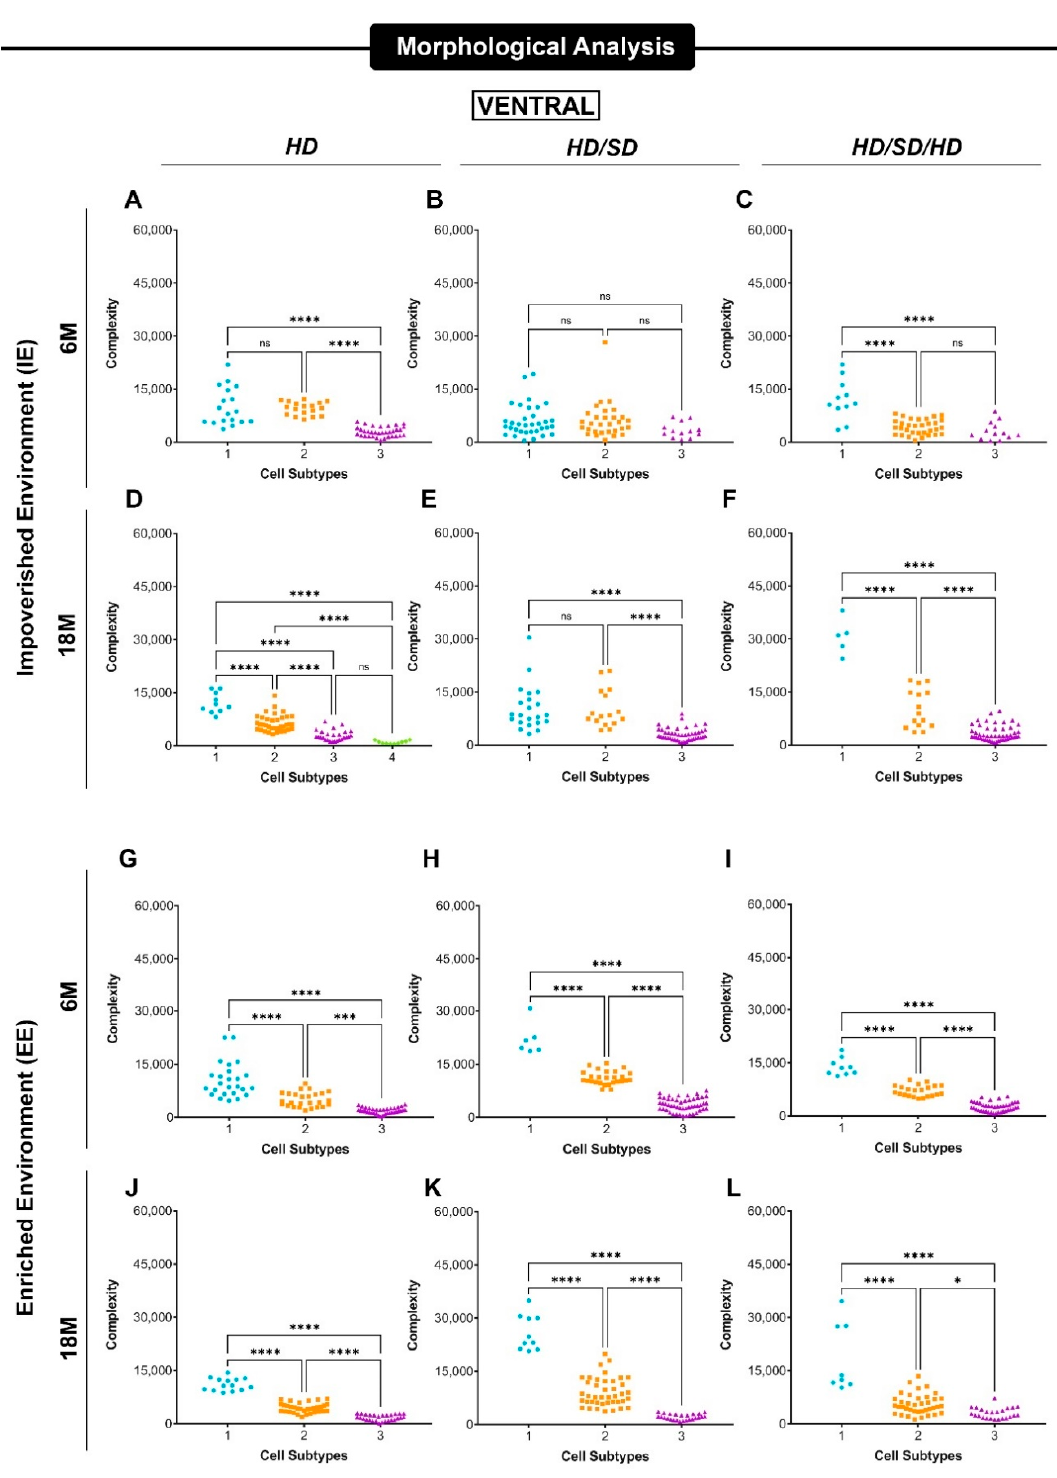
Figure 5. Mean values of astrocyte morphological phenotypes based on the cell arborization complexity at the external one-third of the molecular layer of the ventral dentate gyrus. Impoverished environment—IE ( A – F ); Enriched environment—EE ( G – L ), age (6M—6-month-old; 18M—18-month-old) and masticatory regimen (HD, HD/SD, and HD/SD/HD). Morphological complexity is expressed as Mean/SD. Astrocyte morphotypes are indicated as 1-4 under each colored dataset. HD: hard diet/pellet; SD: soft diet/powder food; * p < 0.05, ** p < 0.01, *** p < 0.001 and **** p < 0.0001; ns, not significant.